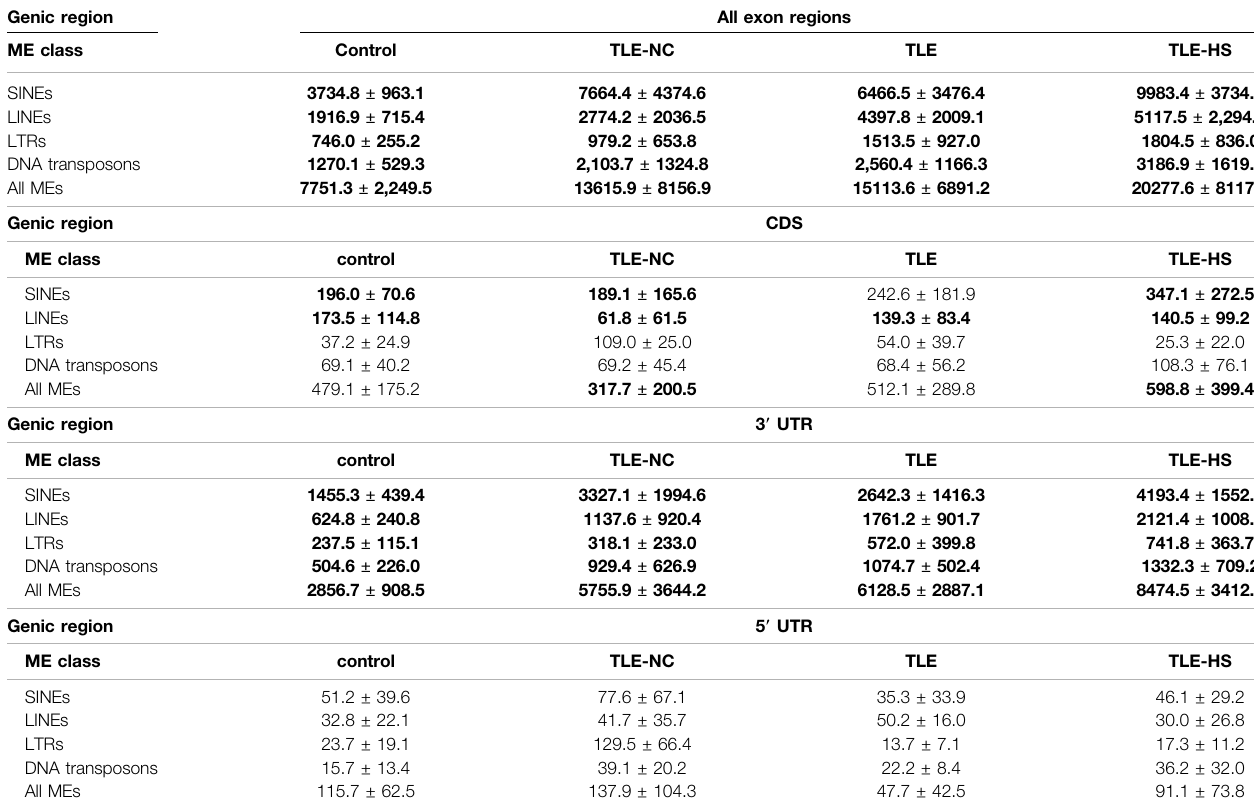
TABLE 2 | Contribution of mobile elements (MEs) to gene transcripts in human epilepsy groups. Genic region